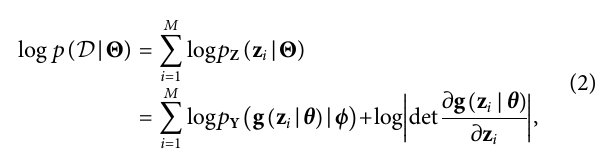
Frontiers in Energy Research |